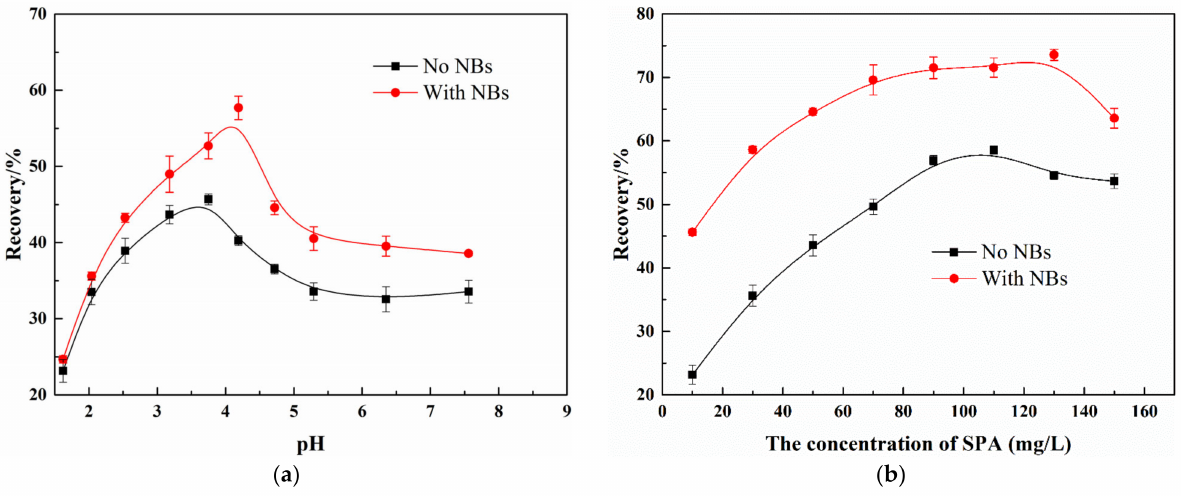
Figure 3. The effect of pulp pH ( a ) and SPA concentration ( b ) on the flotation recovery of rutile and garnet: ( a ) the concentration of SPA is 50 mg/L, and ( b ) the pH of the pulp is